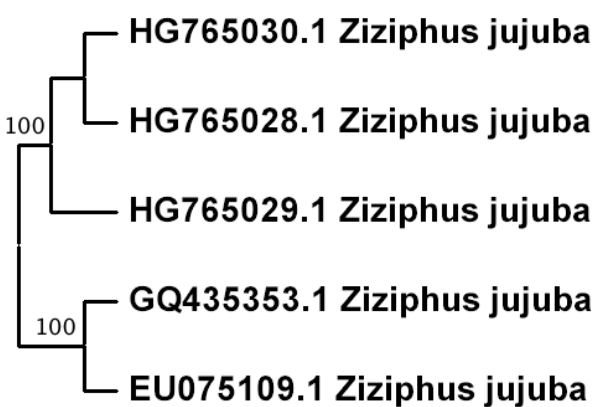
Figure 7. Maximum parsimony phylogenetic tree of jujube cultivars based on trnH-psbA sequences (Numbers above branches are boot- strap value).